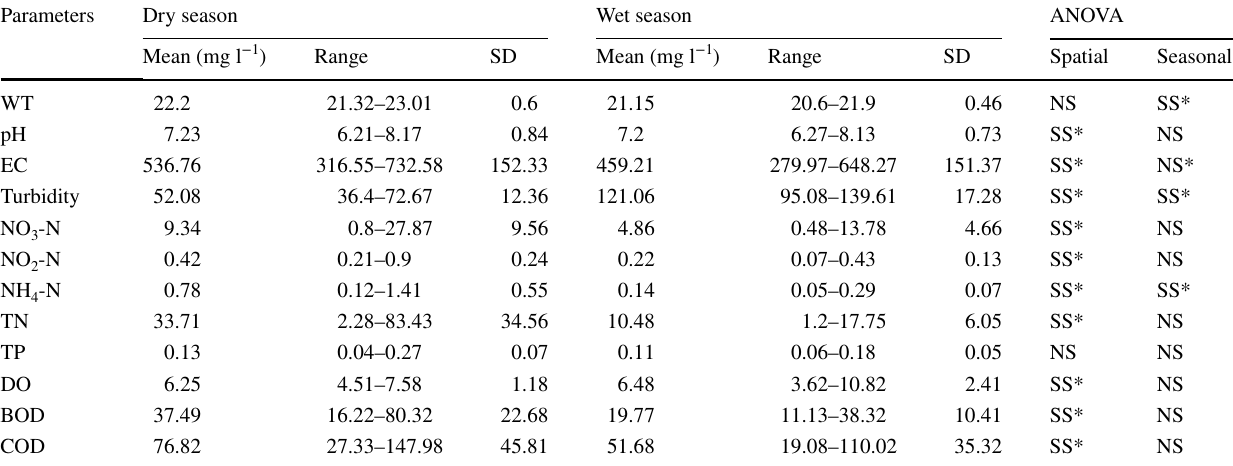
Table 3 ANOVA relation of physicochemical parameters at different sampling location and different season